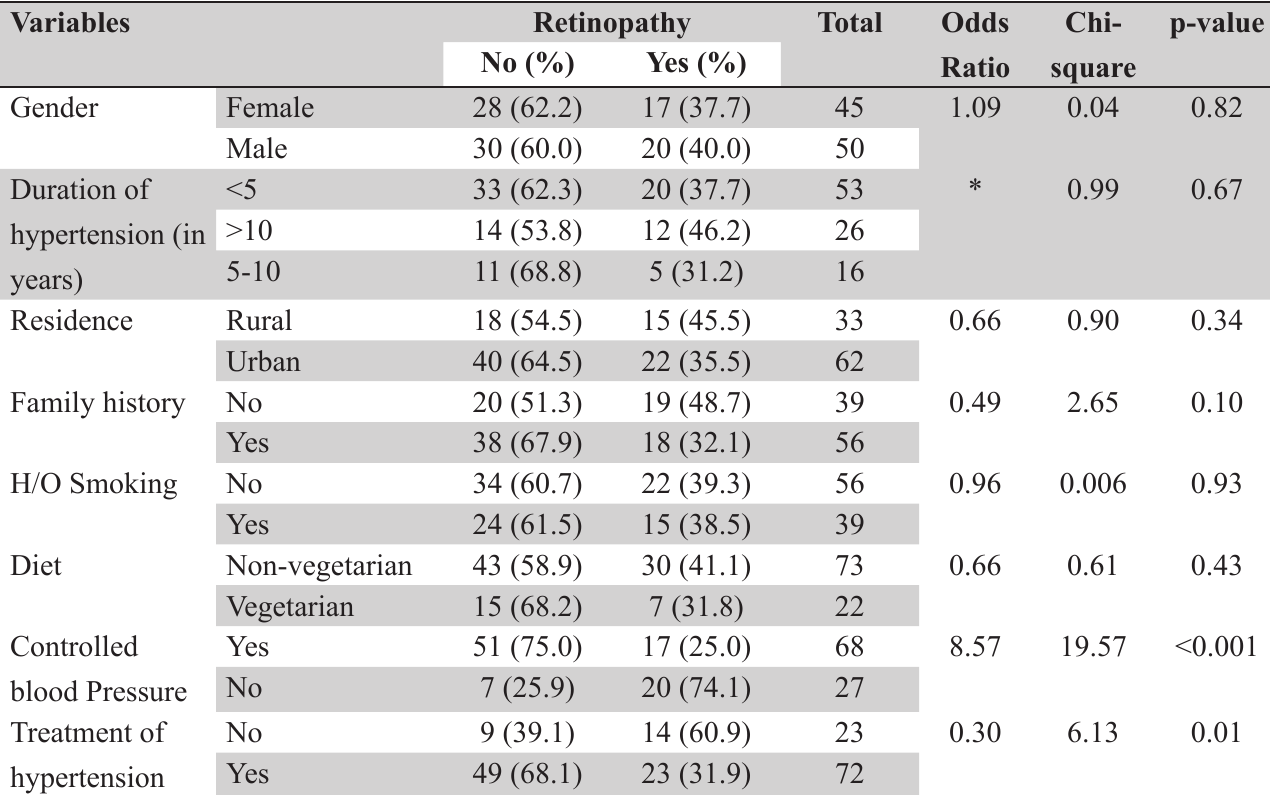
Table 2. Relationship between hypertensive retinopathy with different variables.